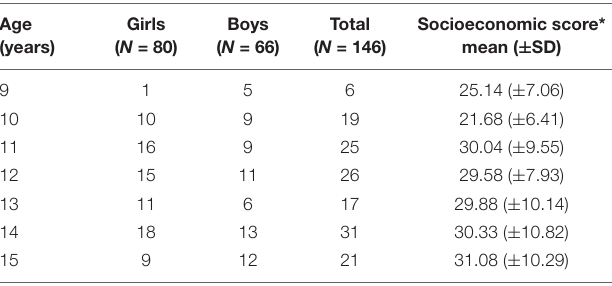
TABLE 1 | Demographic characteristics of the sample, per